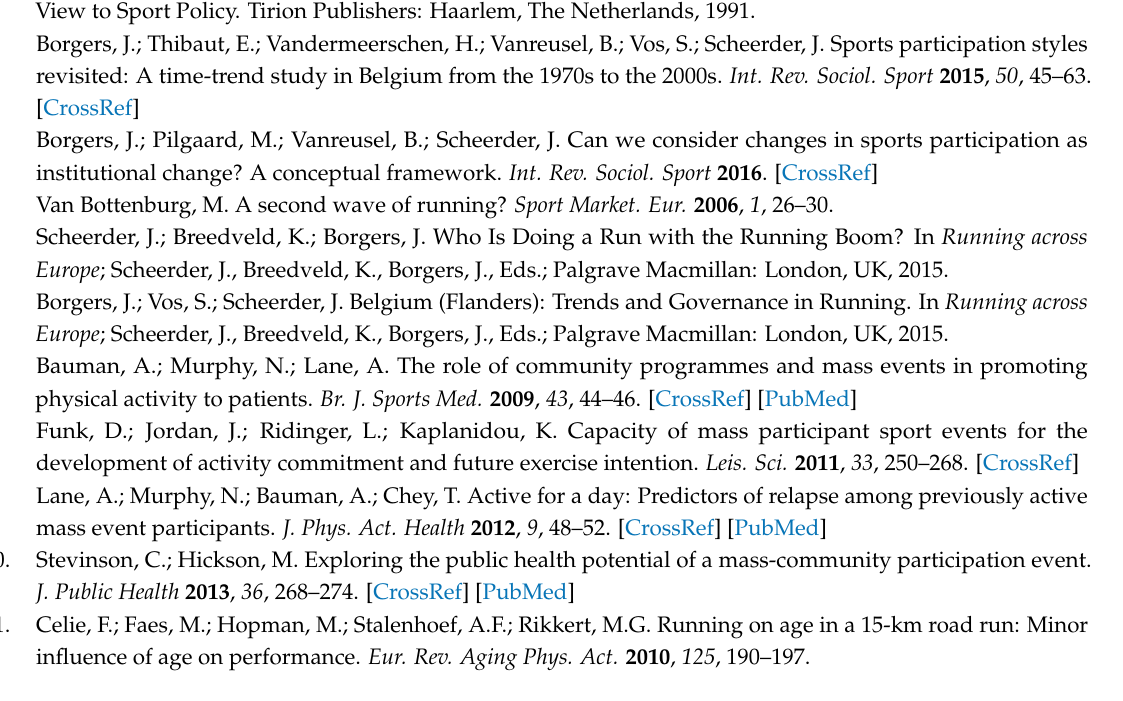
Table S1: SPSS data file of the